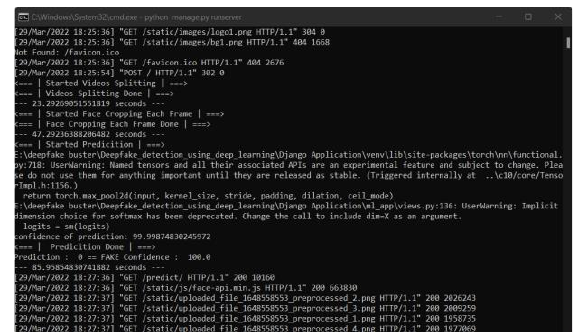
Fig. 11. Confidence of the